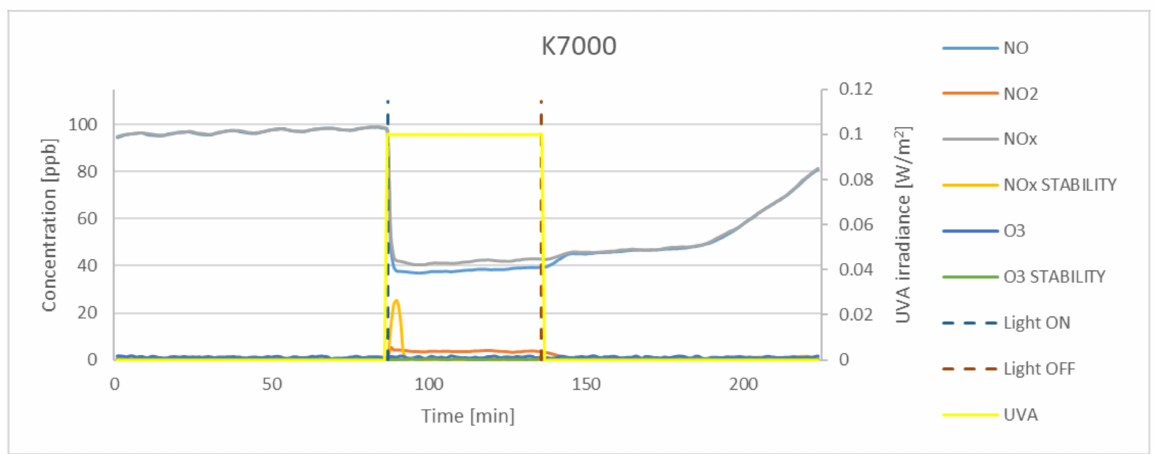
Figure 7. The oxidation of NO in the photocatalytic reaction with concentrations of NO 2 , NO x , and O 3 measured for K7000. Data on UVA irradiation are shown in the supplementary chart. Dashed lines indicate the time of light on and off.